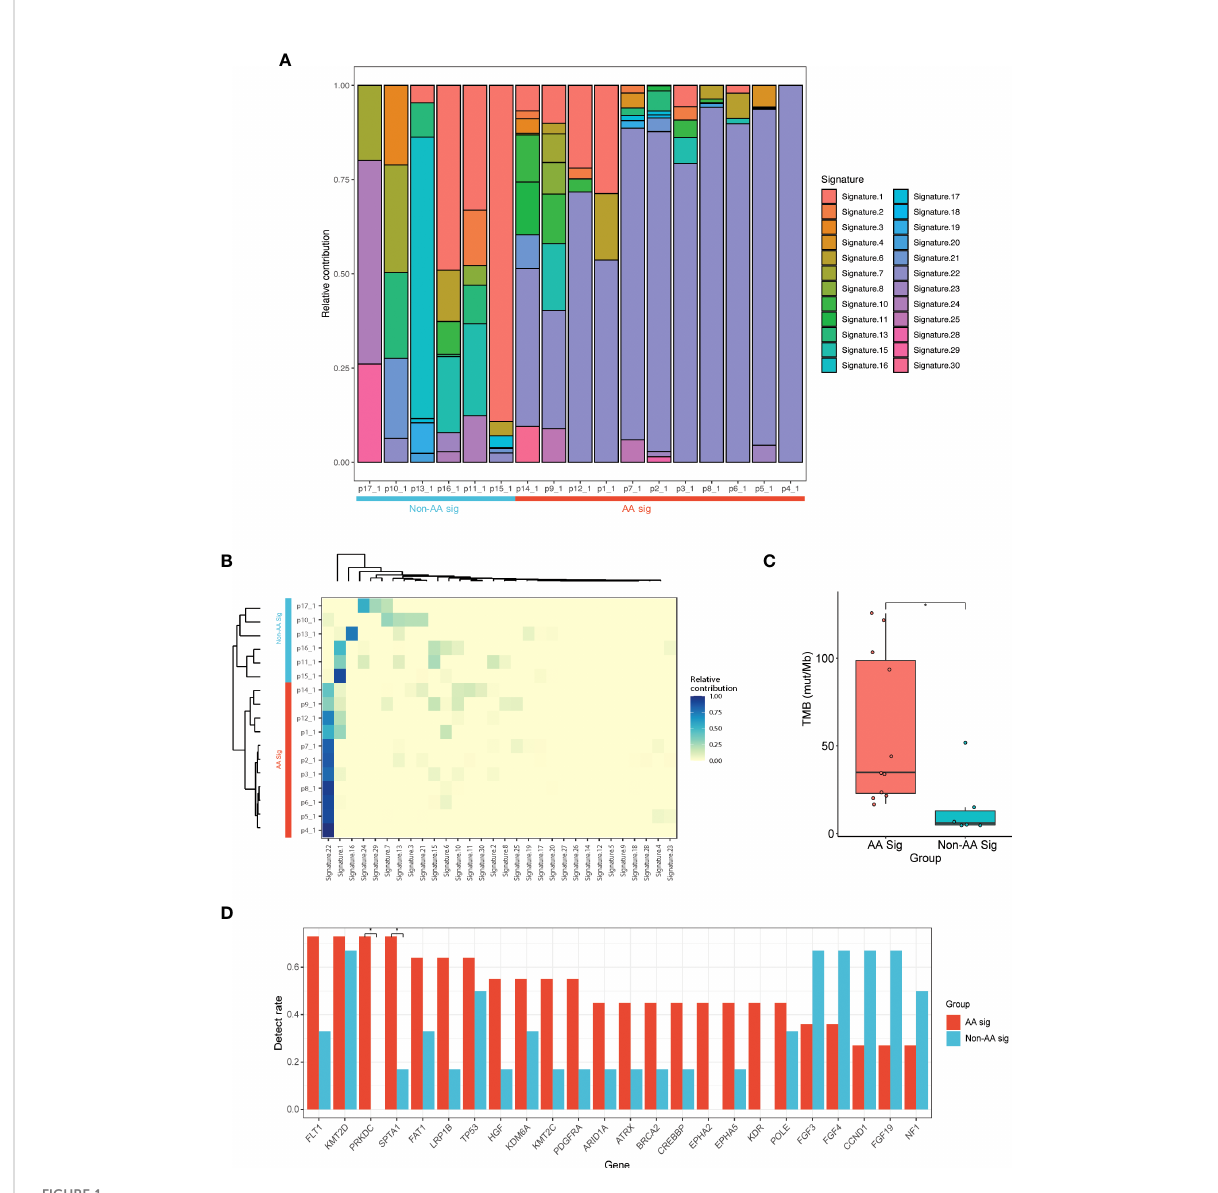
FIGURE 1 NGS of UC patients with or without AA signature. (A) Landscape of mutation signatures of AA UC tumors and non-AA UC tumors. Patient primary UC samples were labeled as p1_1 - p17_1. (B) Hierarchical clustering of mutation signatures revealing AA signature (AA Sig) and non-AA signature (Non-AA Sig) group. (C) Bar plot of TMB representing median TMB for AA UC tumors versus non-AA UC tumors. (D) The detection rate of the top 24 mutated genes in all patients. *p < 0.05; NGS, next-generation sequencing; AA, aristolochic acid; UC, urothelial carcinoma; TMB, tumor mutational